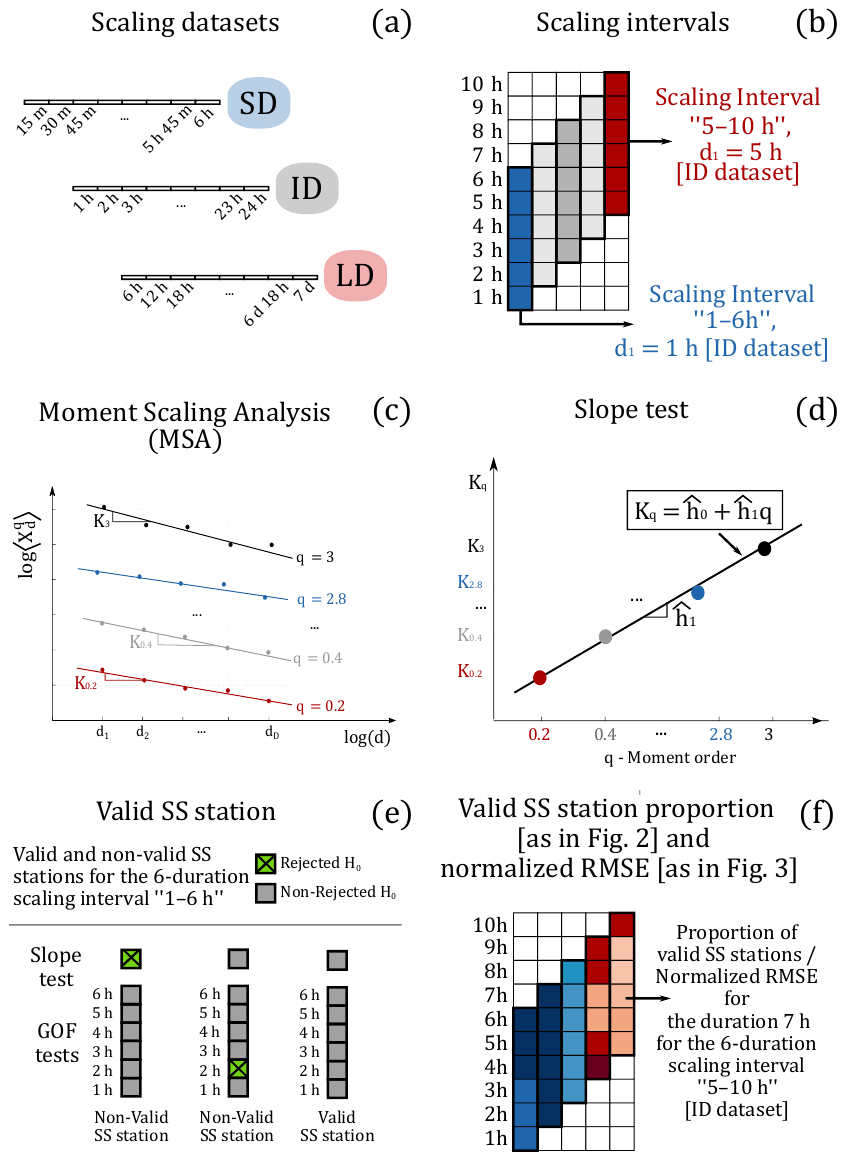
Figure 1. Methodology steps: (a) definition of the SD, ID, and LD scaling datasets; (b) identification of durations and scaling intervals within each matrix of Figs. 2 and 3; (c) moment scaling analysis (MSA) regression for the estimation of the slope coefficients K q ; (d) slope test: regression of K q on the moment order q and Student’s t test for the null hypothesis H 0 : ˆ h 1 = K 1 ; (e) examples of valid and non-valid SS stations according to the slope and GOF tests; (f) example of valid SS station proportion values and normalized RMSE values, r x represented, in Figs. 2 and